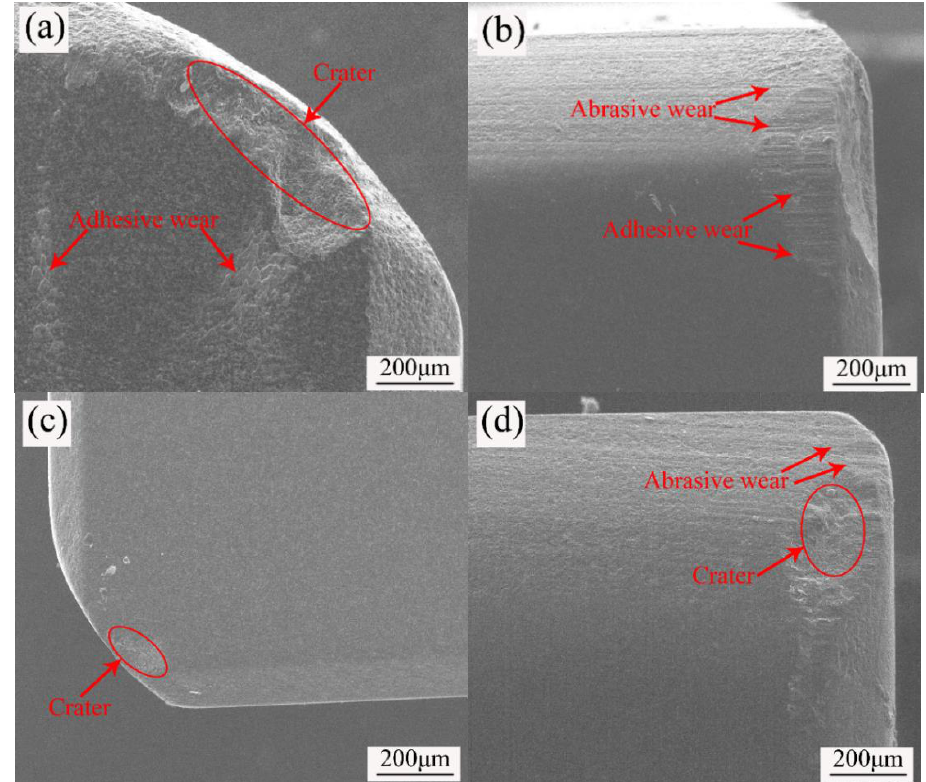
Figure 8. Wear profile of the rake faces of ( a ) the ATCN-C10 ceramic tool and ( c ) the ATCN-C@10 ceramic tool, the flank faces of ( b ) the ATCN-C10 ceramic tool and ( d ) the ATCN-C@10 ceramic tool (test conditions: depth of cut α p = 0.2 mm, feed rates 𝑓 = 0.102 mm/r, υ = 300 m/min).